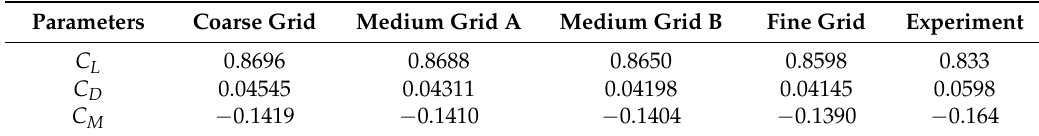
Table 2. Comparison of aerodynamic coefficients at AoA = 4.12 ◦